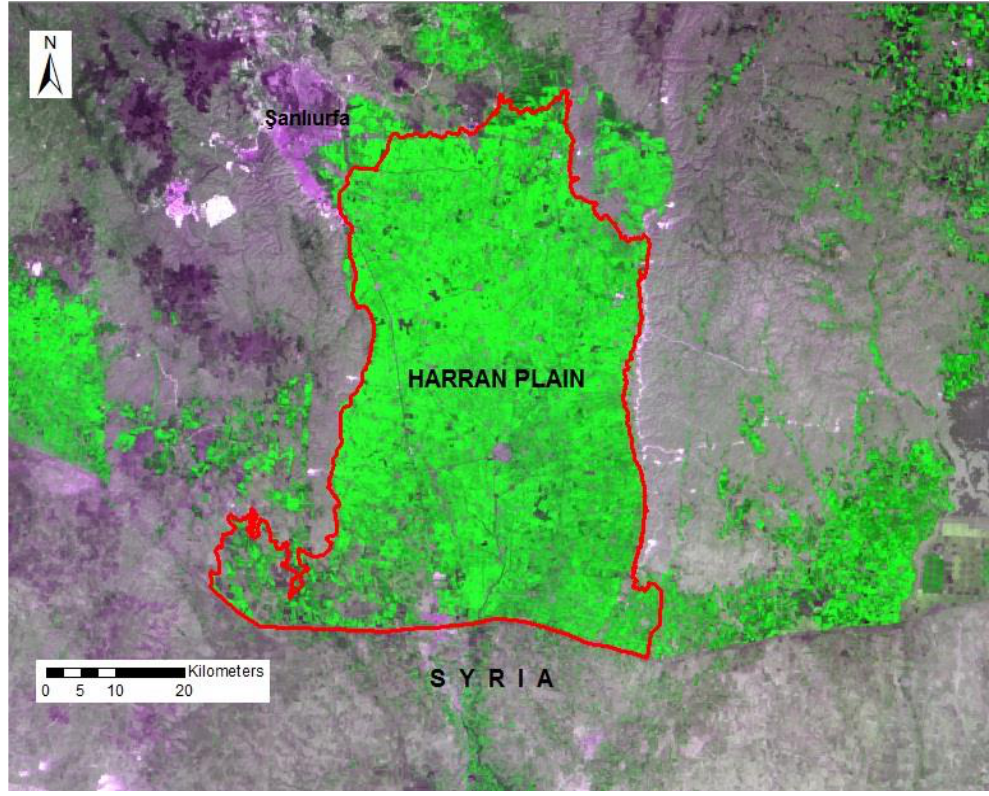
Figure 2. Harran Plain irrigation areas (Source: Prof. Dr. M. Ali Çullu).